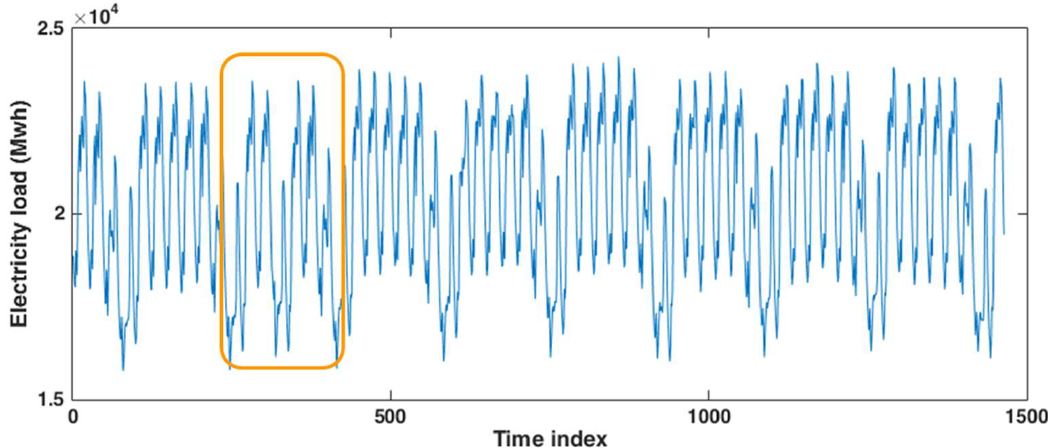
61.72 Green cells represent the MBE values obtained from the bootstrap series for the Polish data set lower (in absolute values) than those obtained from the original series. Based on Tables 9 and 10, we can see that SSA.KM.N can improve the accuracy of 24 and 36 steps ahead of electricity load forecasting for the Polish data using the NNAR model, while KM.N fails to improve forecasting accuracy for this model. On the other hand, the KM.N bagging method works well on the DSHW model, while SSA.KM.N does not perform so well. However, both of them succeeded in increasing the accuracy of fore- casting for the ARIMA model. We can see from Table 10 that implementing the bagging method on Polish data does not reduce the MAPE values in the case of the TBATS model. Still, it makes the MBEs smaller (in absolute values) than those obtained from the original data (Table 11). Further- more, although the RMSE and MAPE values of the DSHW model decreased with bagging, the results were the opposite when analyzing the MBE values. SSA.KM.N gives better outcomes for the NNAR model, while KM.N is better for the DSHW model. 3.3. Application to the Hourly Electricity Load of Java-Bali, Indonesia To show the generality of the implementation of bagging methods in electricity load forecasting, we also discuss the hourly electricity load of Java-Bali, Indonesia. The data